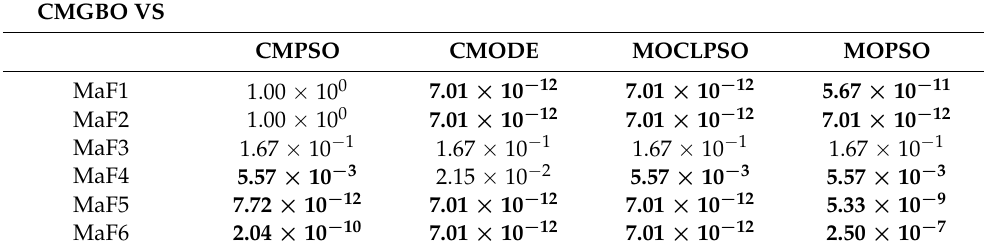
Table 8. The p -values of the Wilcoxon test for the HV